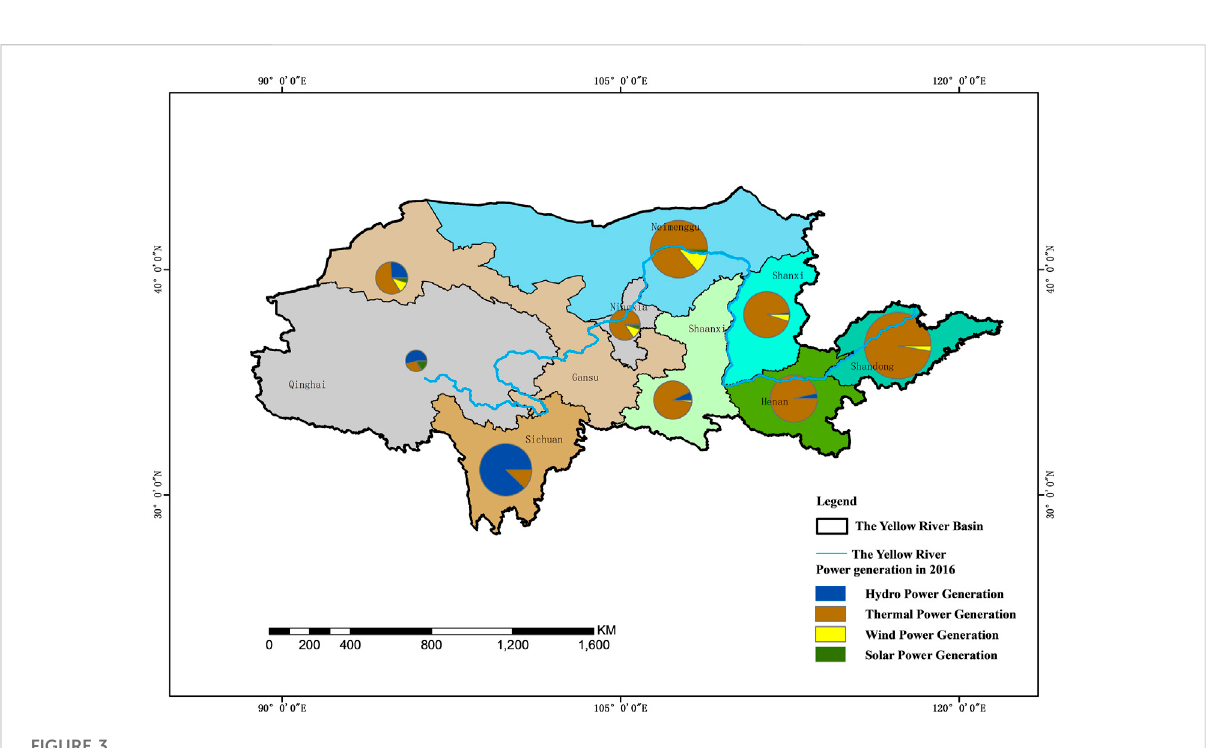
FIGURE 3 Energy structure of the Yellow River basin in